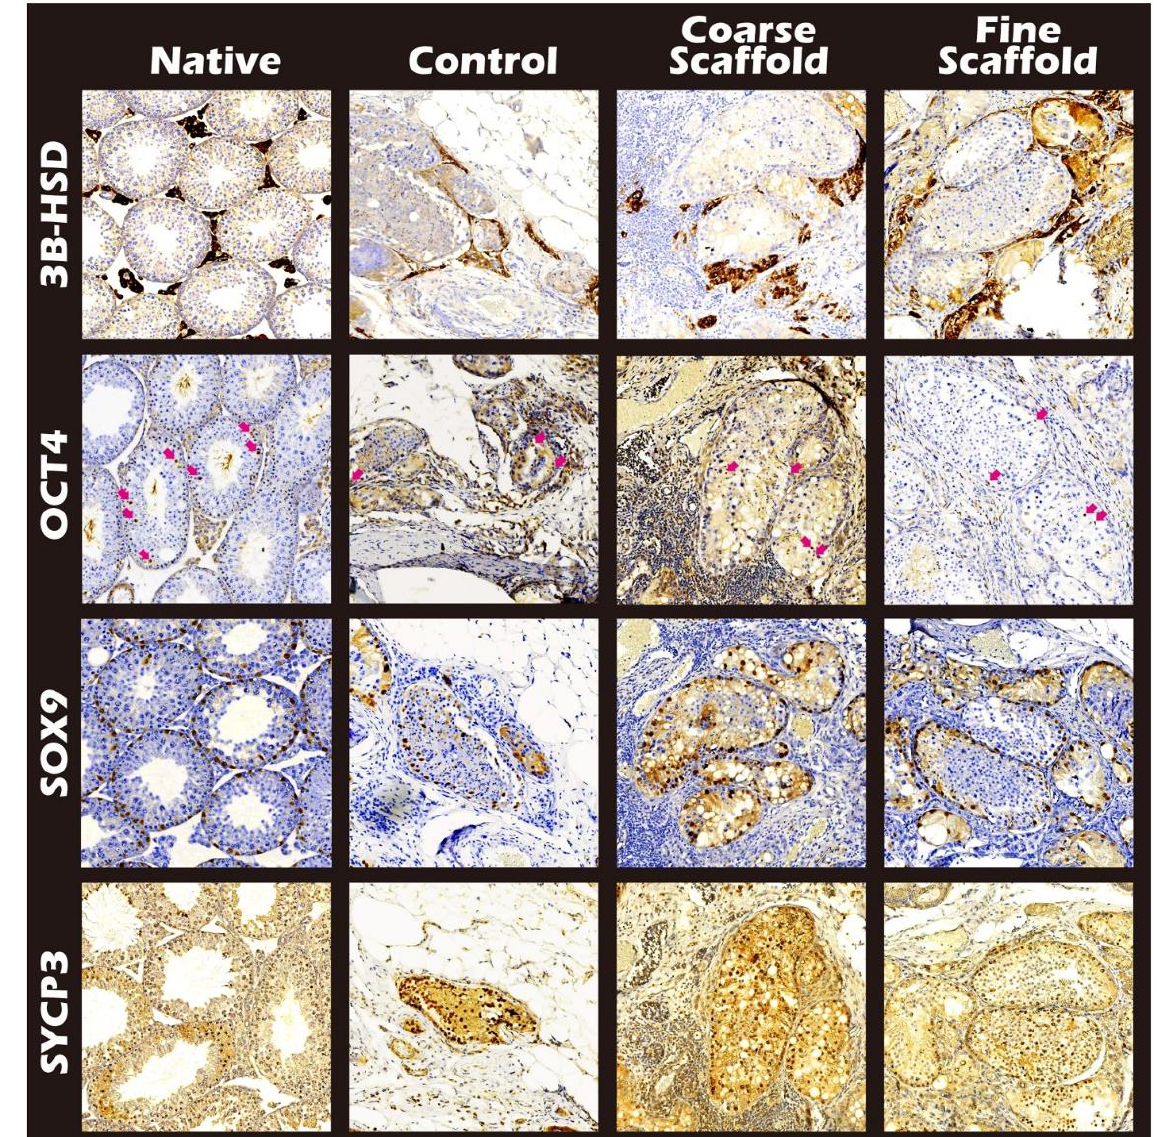
Figure 7. Various functional immunohistochemical staining images of the donor mature testicular tissue within different fineness of PLLA electrospun mats after long-term engraftment. In the images, the first line is the native tissue, and the second to fourth lines are the donor mature testicular tissue encapsulated for 107 days without scaffolds (line 2), the coarse PLLA electrospun mats (line 3), and the fine PLLA electrospun mats (line 4). Positive 3B-HSD stain for Leydig cells (row 1), positive OCT4 stain for spermatogonial stem cells (arrows, row 2), positive SOX9 stain for Sertoli cells (row 3), and the SYCP3 stain (row 4) was required for meiosis during spermatogenesis in all groups, but the existence of spermatogenesis is shown in order of the fine scaffold, coarse scaffold, and control group (Figure 6).